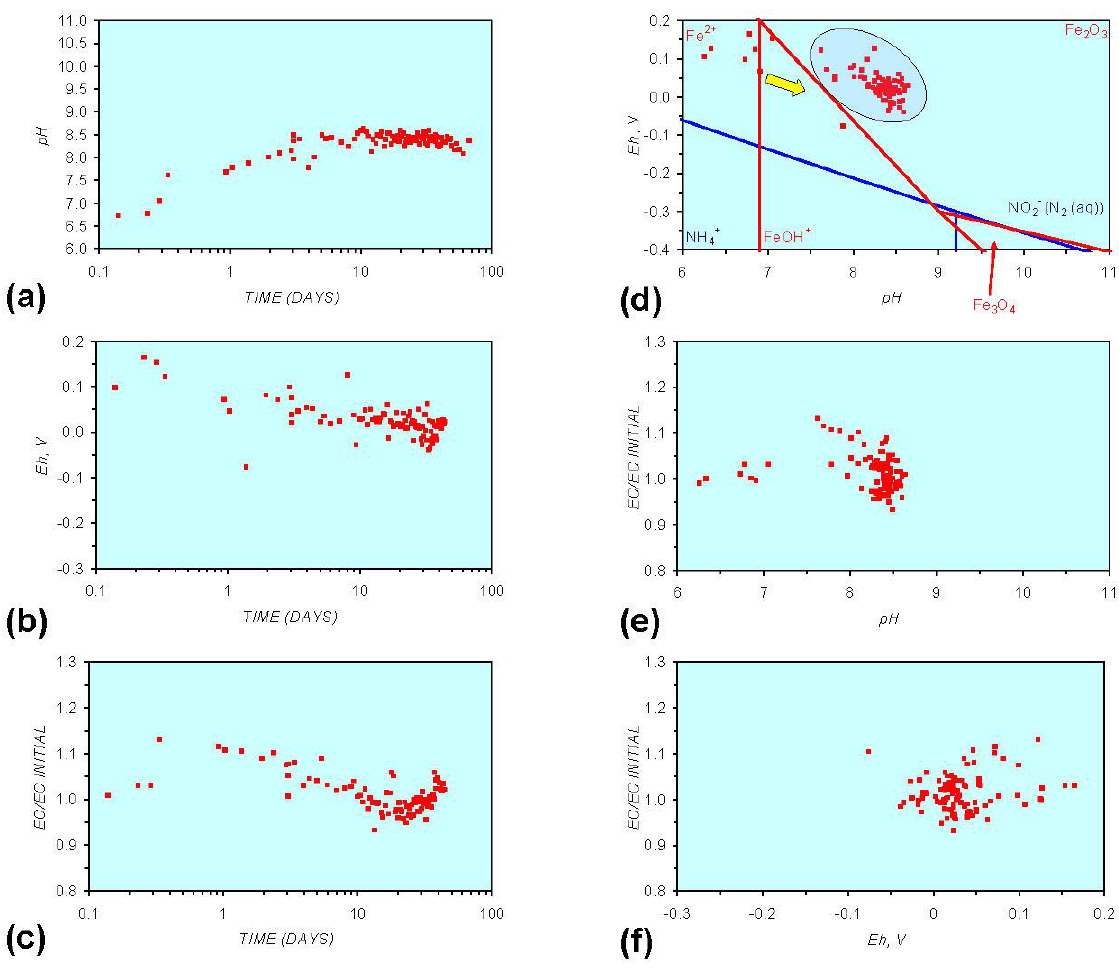
Figure A12. MR12: Ca-montmorillonite, saline water. (a) pH vs. Time; (b) Eh vs. time; (c) EC/EC Initial vs. time; (d) Eh vs. pH (SRE ringed); (e) pH vs. EC/EC Initial; (f) Eh vs. EC/EC Initial; Arrows indicate decreasing SV and increasing